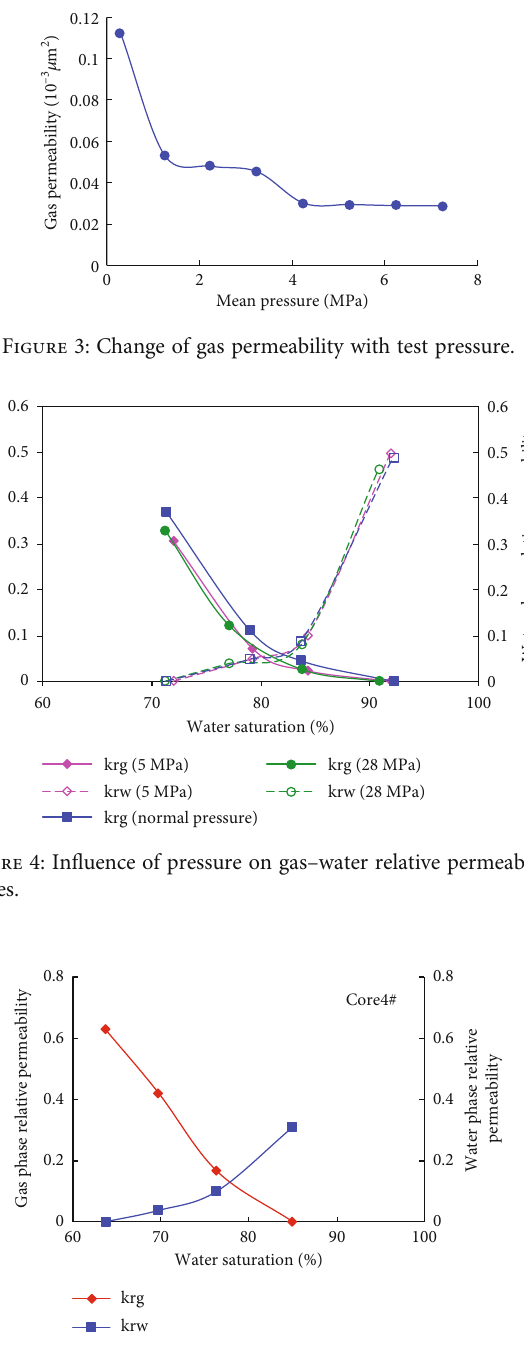
Figure 5: Results of the gas – water permeability curve of core No. 4.